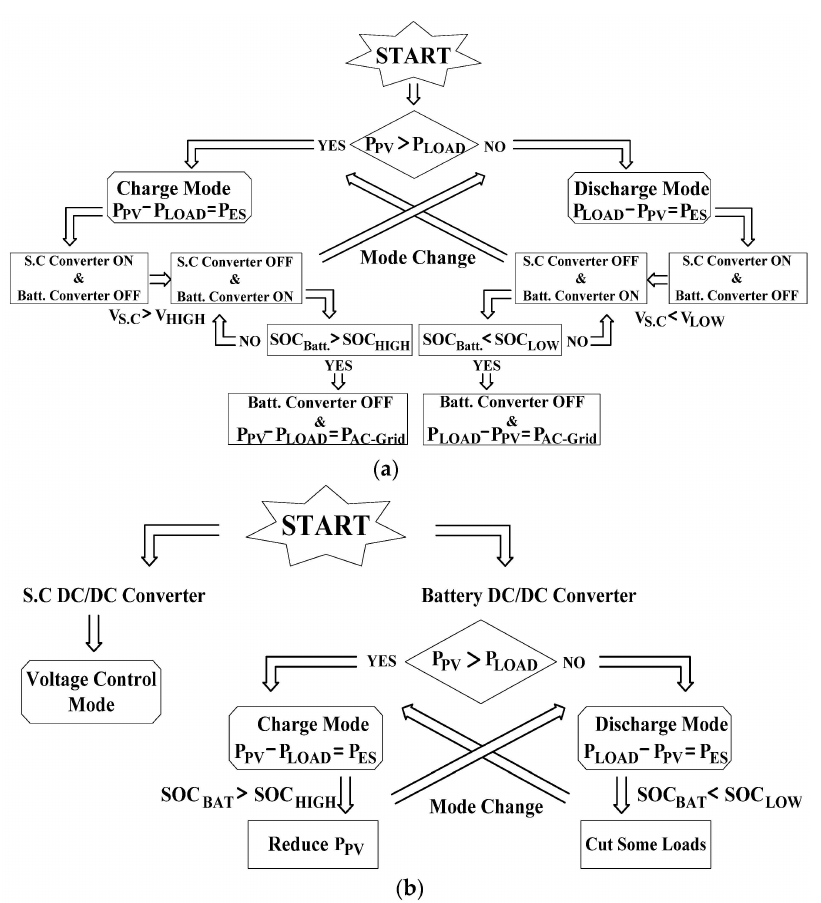
Figure 2. Power management logic: ( a ) Grid-tied mode; ( b ) Islanded